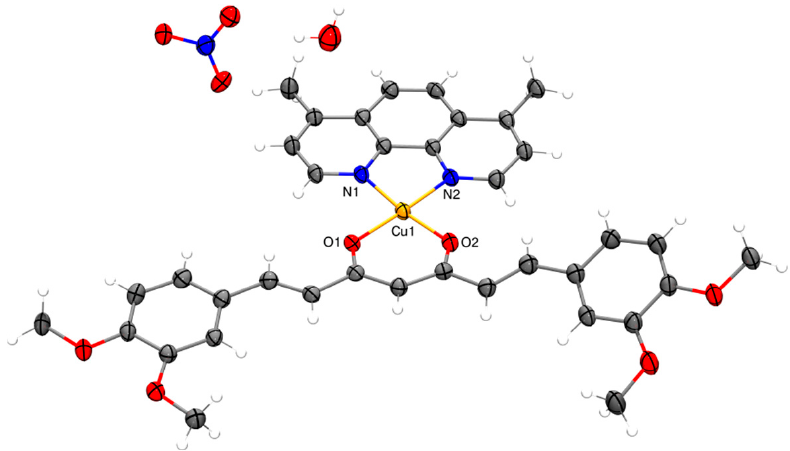
Figure 9. Molecular structure of complex D5CuL2 with displacement ellipsoids at 50% probability level.